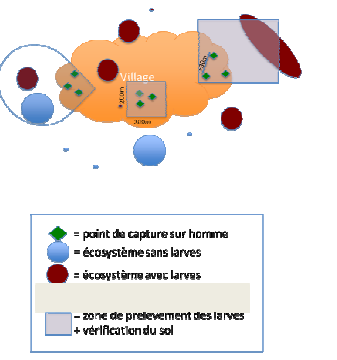
Figure 1 : Zones where entomological measurement were taken The measuring campaign of 2011 (from August to December) was to acquire the key data to develop prediction models for larvae production. The 2012 campaign (from July until December) had a double objective: - validation of entomological models (for larvae and adult vectors) based upon the 2011 data in order to establish maps of vectorial risks; - show the feasibility of a strategic larvicide’s procedure based